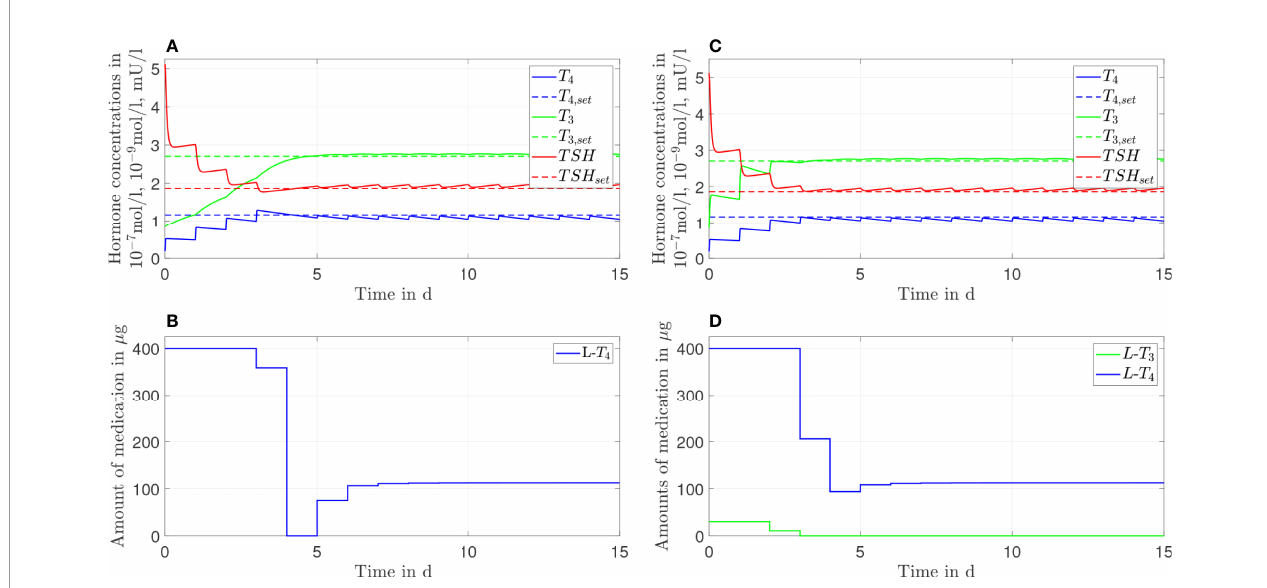
FIGURE 6 | Simulation results of an L-T 4 monotherapy (A, B) and an L-T 3 /L-T 4 combined therapy (C, D) for G''' D1 = 1.2G D1